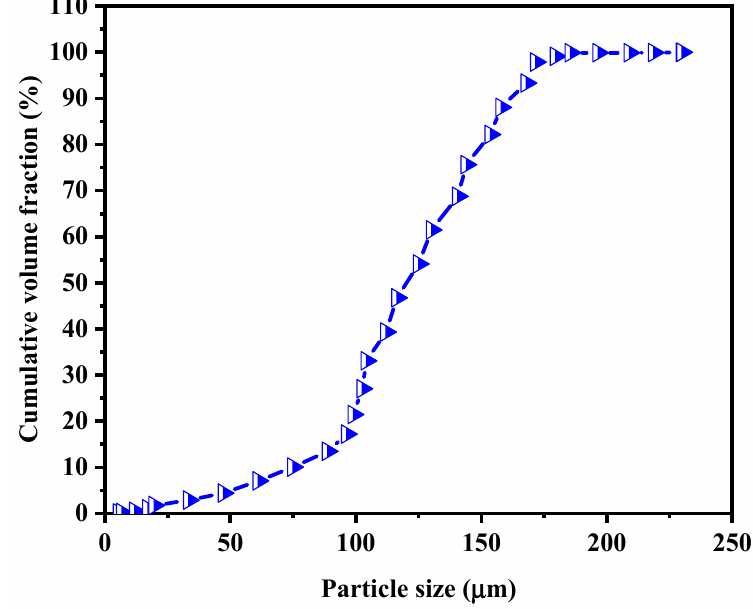
Figure 2. Particle size distribution of the original soil.